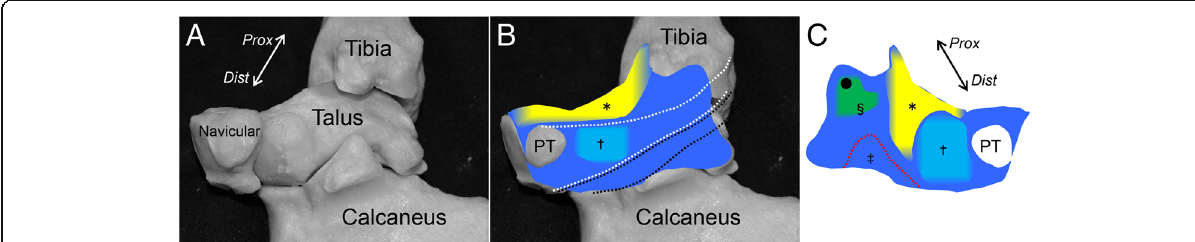
Fig. 7 Schematic illustrations of the continuous capsule on the medial ankle. a Underlying bones of the right medial ankle on the continuous capsule. b The outer appearance of the continuous capsule is shown. The fatty tissue (yellow, asterisk) covered the anterior part of the ankle and talonavicular joints. Posterior to the insertion of the posterior tibialis tendon (PT), the cartilaginous tissue, normally referred as the SML (aqua area, dagger), located to form the gliding floor of the tendon (white dotted area). Black dotted area indicates the gliding floor of the flexor digitorum longus tendon. c The continuous capsule shown in ( b ) is posteriorly reflected to show the inner appearance. The fibrous tissue, normally referred as the deep deltoid ligament (green area), connects between the intercolliculus groove of medial malleolus (black circle) and the depression of the medial talus (section mark). The fatty tissue extended medially between the fibrous and the cartilaginous tissues. The cartilaginous tissue covered the talus head. Red dotted area indicates the capsular attachment on sustentaculum tali (double dagger). Prox , proximal; Dist ,